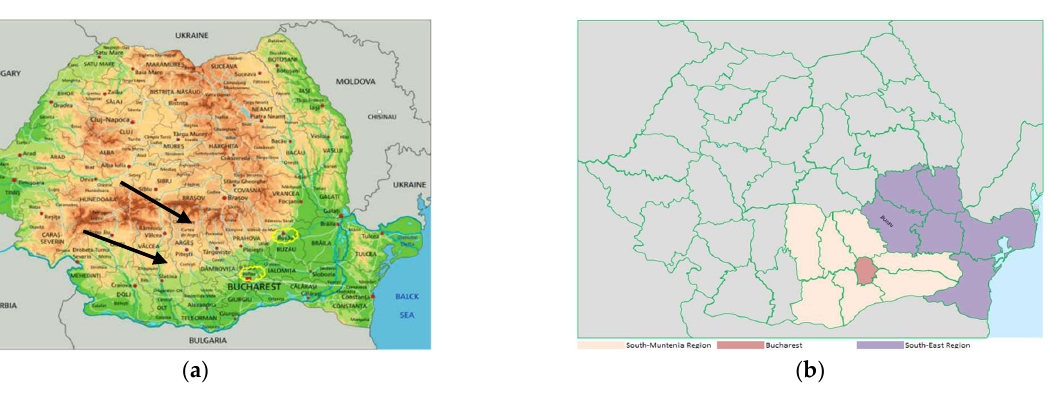
Figure 2. Research area: ( a ) location on the Romanian map of the two areas focused on (South-Muntenia and South-East Regions); ( b ) the administrative map of the South-Muntenia and South-East Regions. Source: adapted representation based on https://harta-romaniei.org/harta-geografica-a-romaniei.html, accessed on 2 August 2022 [34].